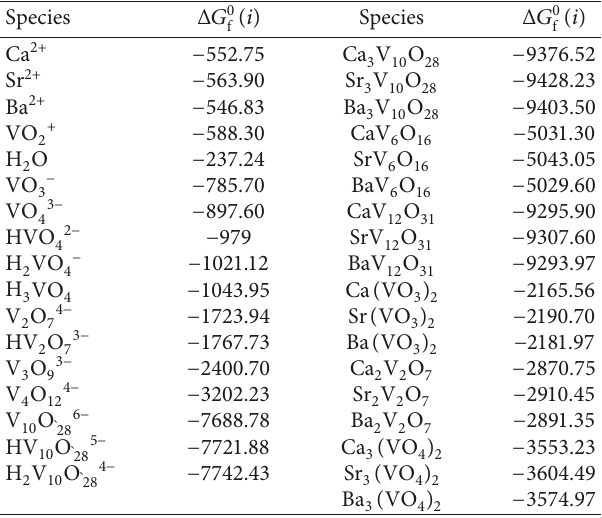
Table 1: Standard Gibbs energy of formation of the soluble and insoluble species at 295.15 K [4,